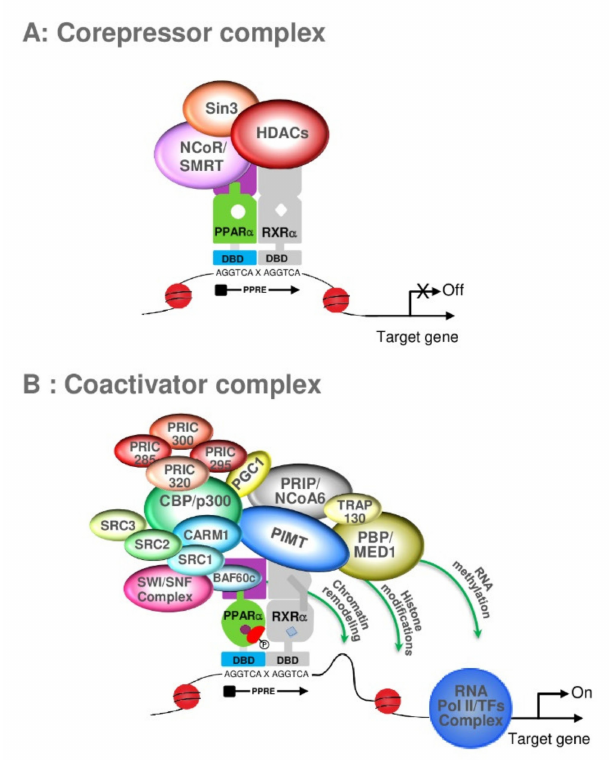
Figure 7. Interaction of PPAR α -RXR α heterodimer with corepressor complex ( A ) or coactivator complex ( B ). ( A ) The corepressor complex, including Sin 3, NCoR/SMRT, and HDAC proteins, is re- cruited to an unliganded PPAR α -RXR α heterodimer, so there is no transcription of the PPAR α -target genes. ( B ) in the presence of PPAR α -ligand, the PPAR α -RXR α heterodimer exhibits a conformational change, leading to the dissociation of the corepressor complex, the recruitment of coactivator pro- teins, and the binding of PPAR α to the peroxisome proliferator response element (PPRE). Different subcomplex modules participate in chromatin remodeling, through the acetylation (SRCs, p300) and the methylation (CARM1) of nucleosomes. Mediator components interact with PPAR α and promote the recruitment of the basal transcription factors (TFs) to establish a connection with the RNA polymerase II to transcription of PPAR α -target